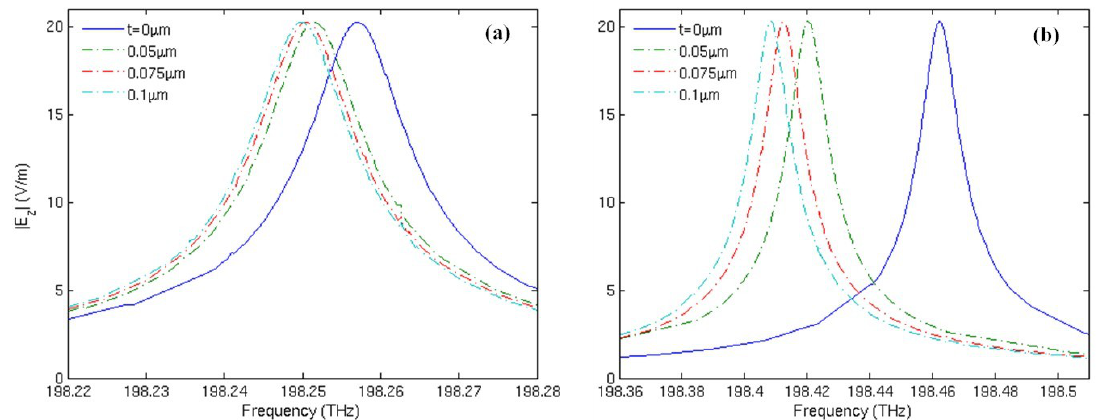
Figure 8. Resonant frequency spectrum of mode 27 with respect to the increase of substance layer thickness t . (a) The traditional microring sensor. (b) The metamaterial sensor.